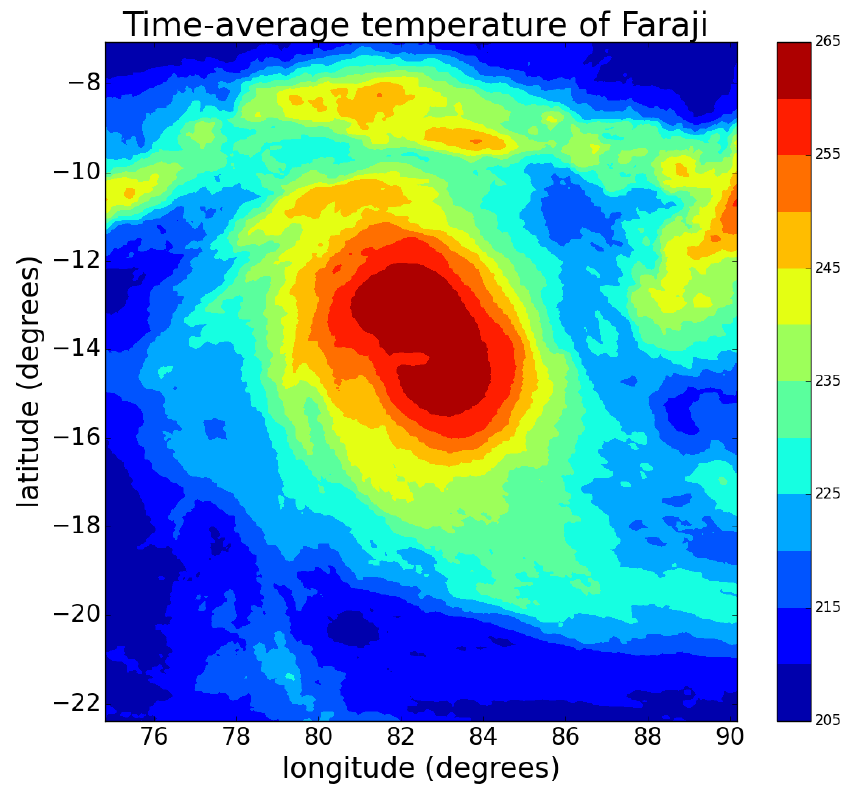
Figure 2. Temperature (in Kelvin) of the Faraji cyclone averaged over each time instant of the